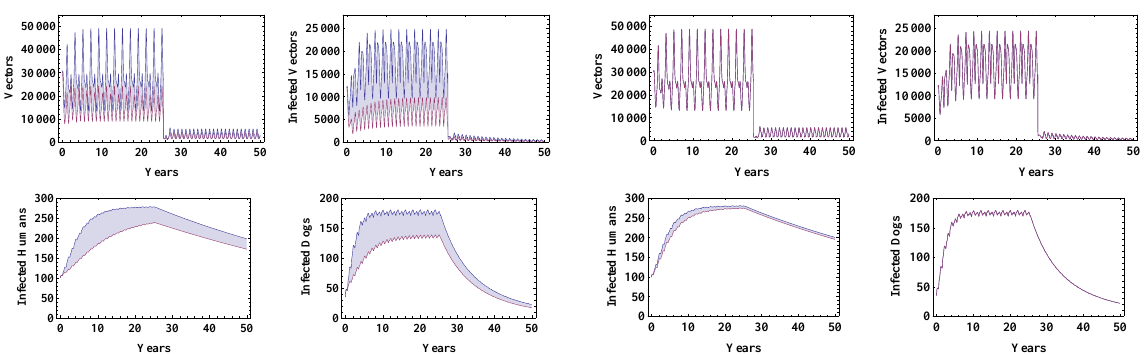
Fig. 4. Case (iii): Model behavior with variability in d m ( t ) . Fig. 5. Case (iv): Model behavior with variability in p V N .